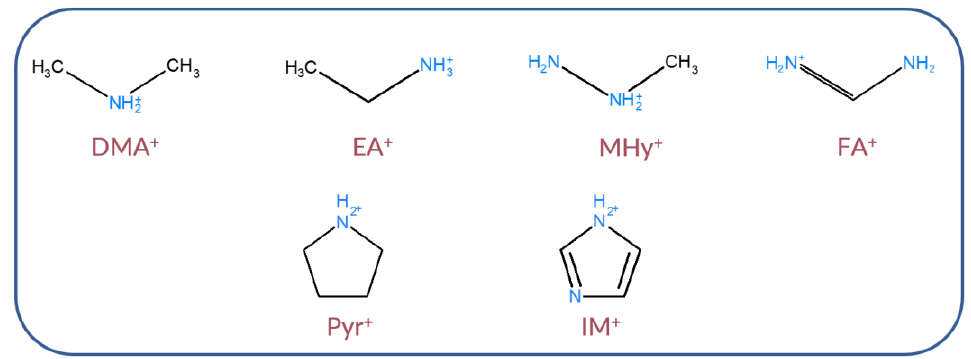
Figure 1. Chemical structures of organic cations used for the synthesis of [A]Mn(H 2 POO) 3 hypophosphite perovskites.